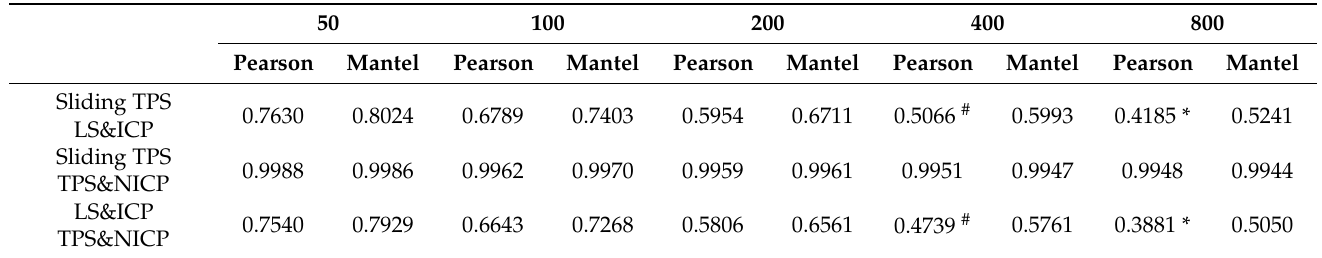
Table 4. Pearson correlations (all p < 0.01, except # , p < 0.05, * = n.s., parametric test) among the vectors of Procrustes distances between each ape cranium and the mean and Mantel tests among Procrustes distance